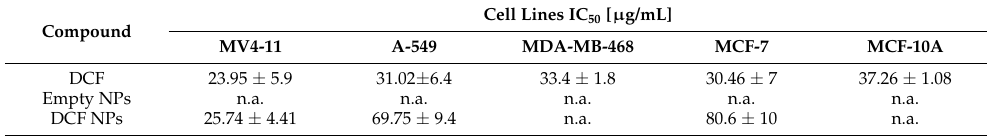
Table 4. The half maximal IC 50 DCF, empty NPs and studied DCF NPs against selected cancer cell lines and non-tumorigenic human breast epithelial cell line